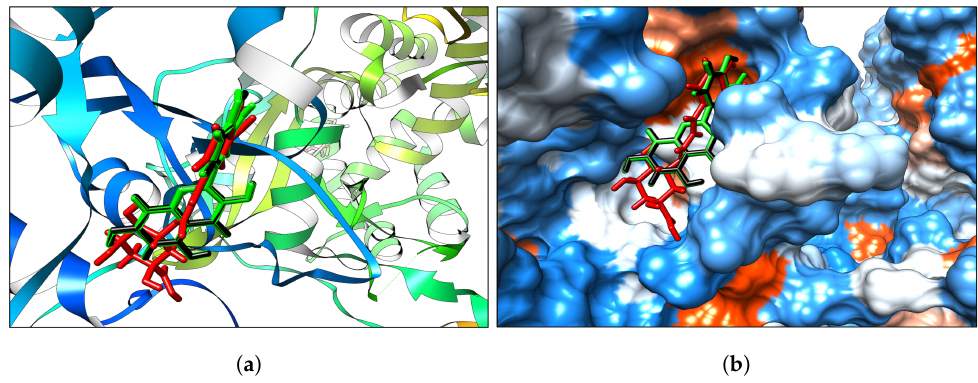
Figure 4. ( a ) NS5 protein Ribbon, ( b ) NS5 hydrophobicity surface with colors ranging from dodger blue for the most hydrophilic, white for neutral (i.e., 0.0 value), to orange red for the most hydrophobic. (Green–Quercetin, black–Kaempferol, and red–Chlorogenic